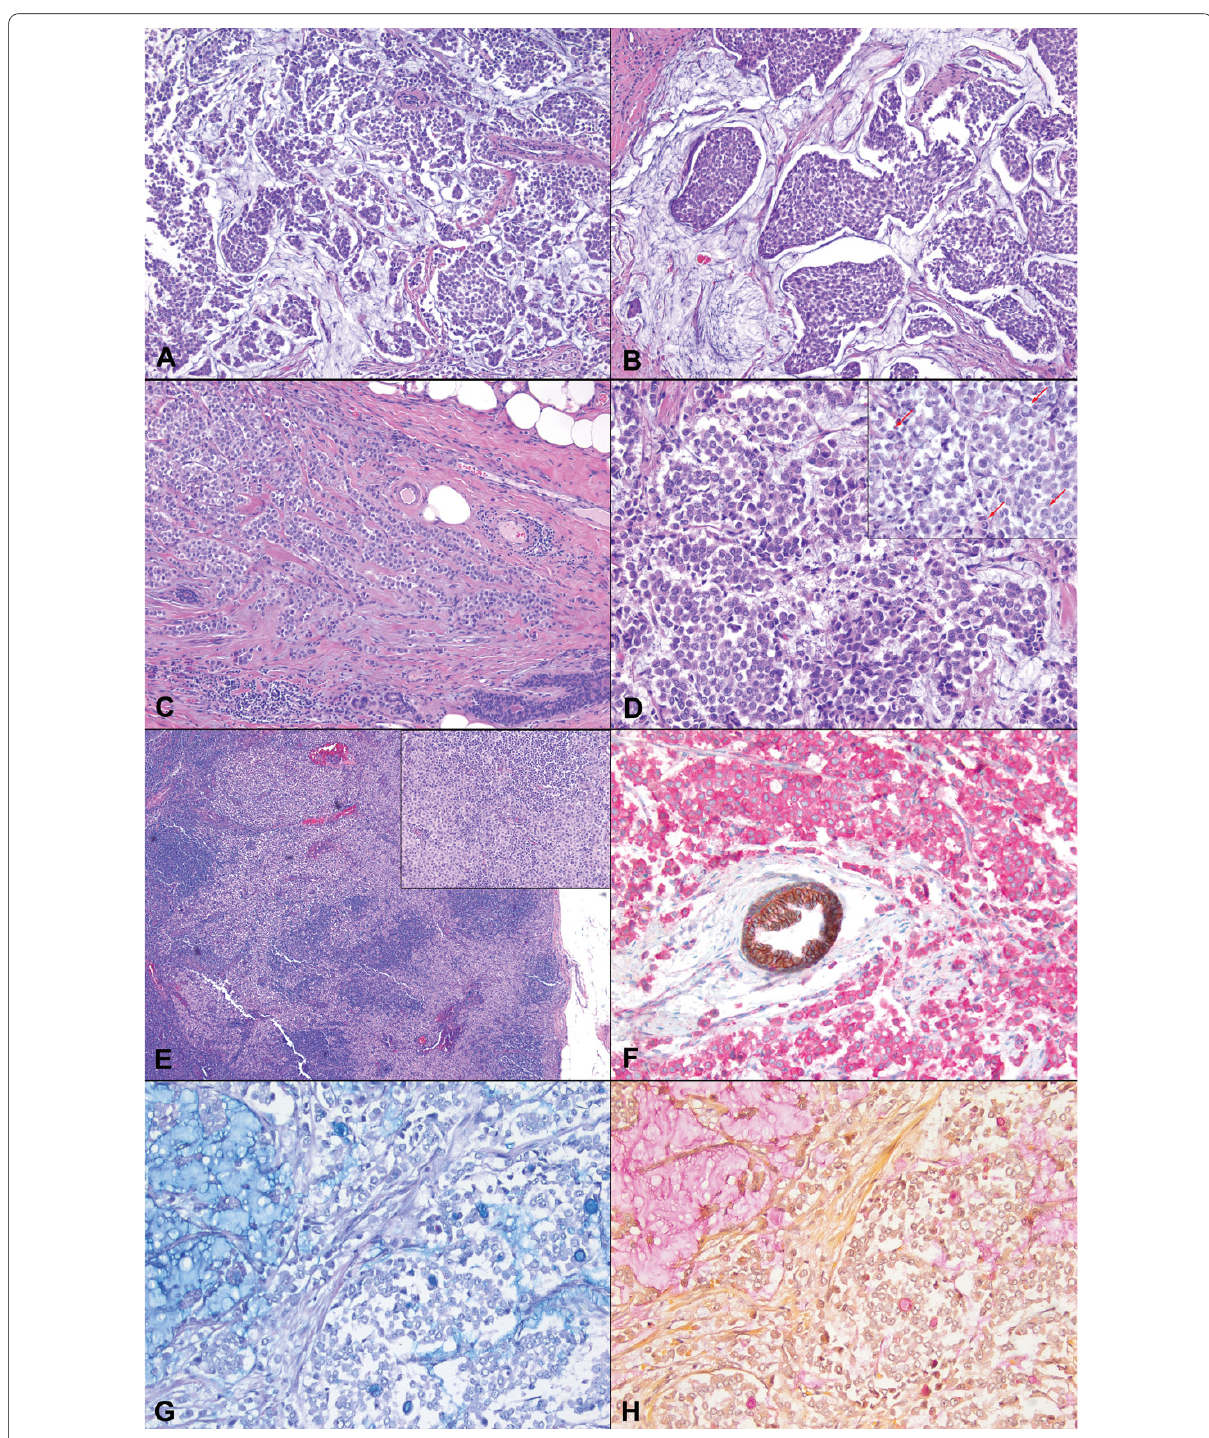
Figure 1 A case of invasive lobular carcinoma of breast with extracellular mucin . The tumor showed discohesive (A, H&E, ×100) and nested (B, ×200) growth with abundant extracellular mucin. At the periphery, the tumor cells formed cords and single files (C, ×100). Cytologically, the tumor cells were small to medium in size and relatively uniform (D, ×400), with scattered signet ring cells present (D inset, arrows, ×400). A sentinel lymph node showed metastatic focus of uniform tumor cells (E inset, ×40) in dissociated infiltrating pattern (E, ×200). Immunohistochemical stain revealed complete absence of membranous E-cadherin staining (brown) and the presence of diffuse cytoplasmic p120 staining (pink); a normal duct with membranous staining for both E-cadherin and p120 served as an internal control (F, immunohistochemistry, ×400). Alcian Blue (G, ×200) and Muci- carmine (H, ×200) stains highlighted both extracellular and intracellular